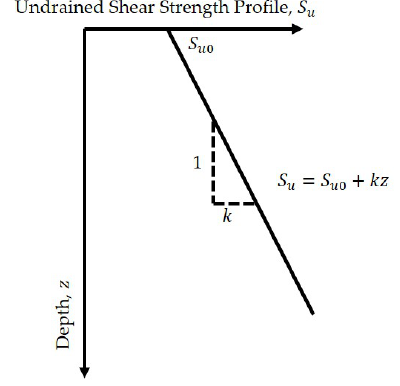
Figure 1. Soil profile of the strength increasing with depth